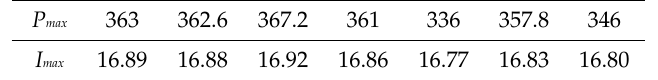
Table 1. Experimental P max and I max values obtained from the FC-42 Evaluation